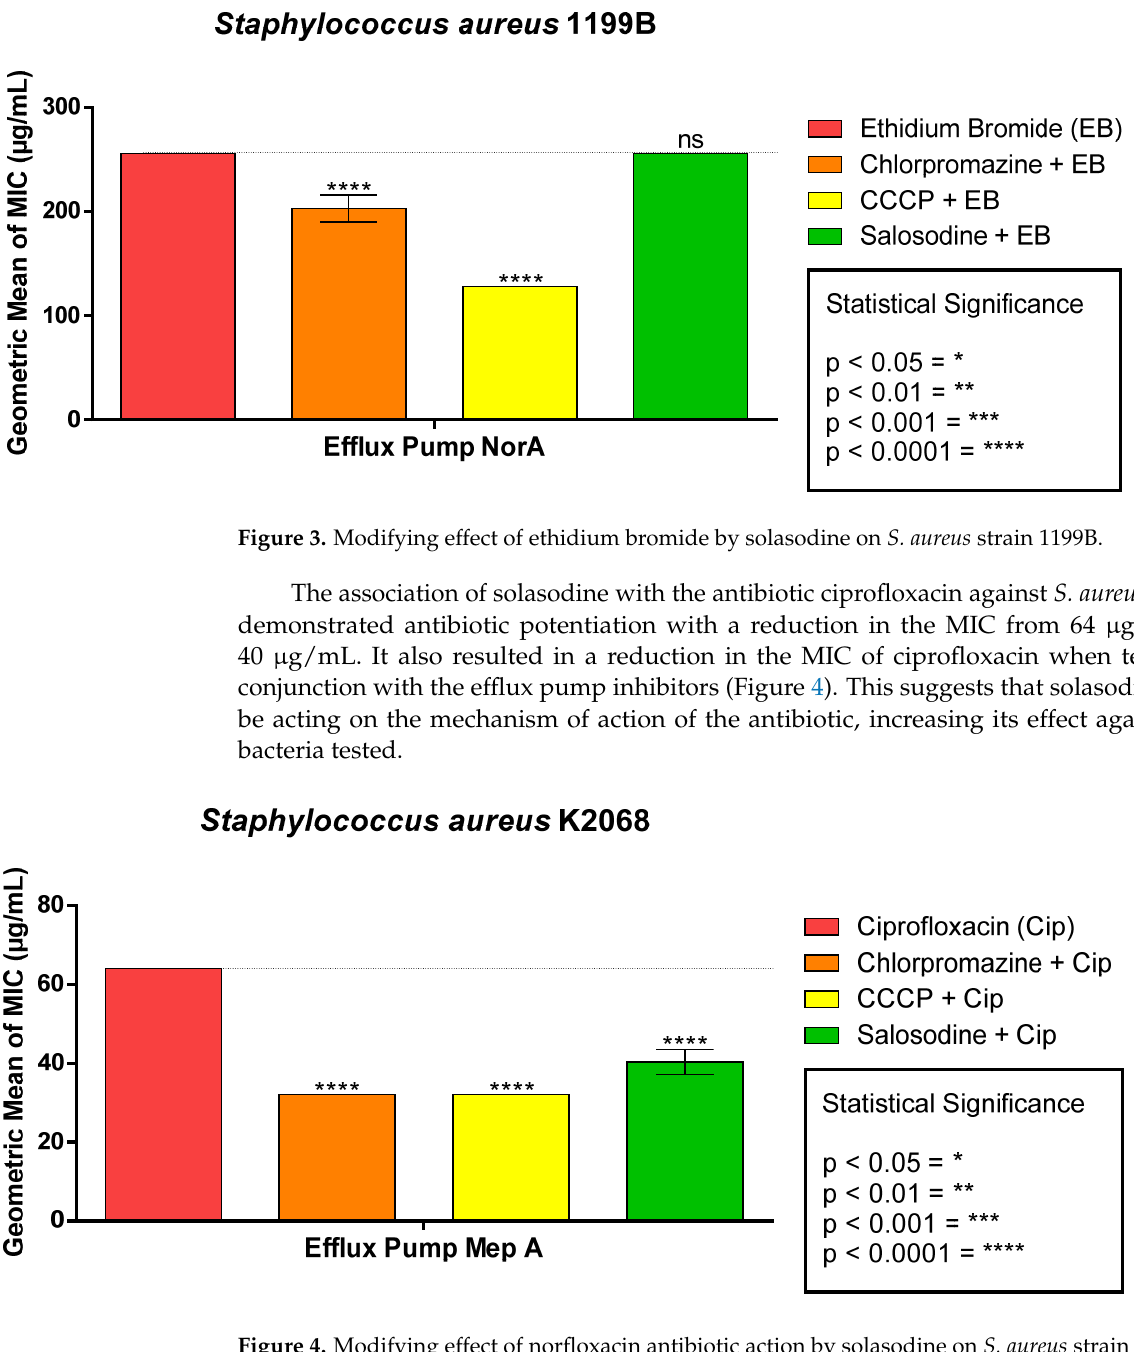
Figure 2. Modifying effect of norfloxacin antibiotic action by solasodine on S. aureus strain 1199B. When solasodine was associated with ethidium bromide, it did not show a statisti-